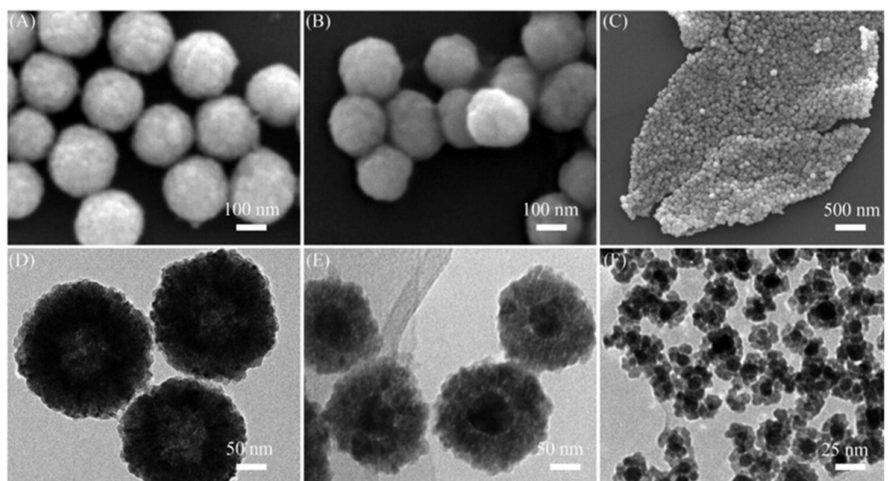
Figure 1. The scanning electron microscopy (SEM) and transmission electron microscopy (TEM) images of Cu 2 O ( A and D ), Ag@Cu 2 O ( B and E ), and Ag@Cu 2 O-rGO ( C and F )